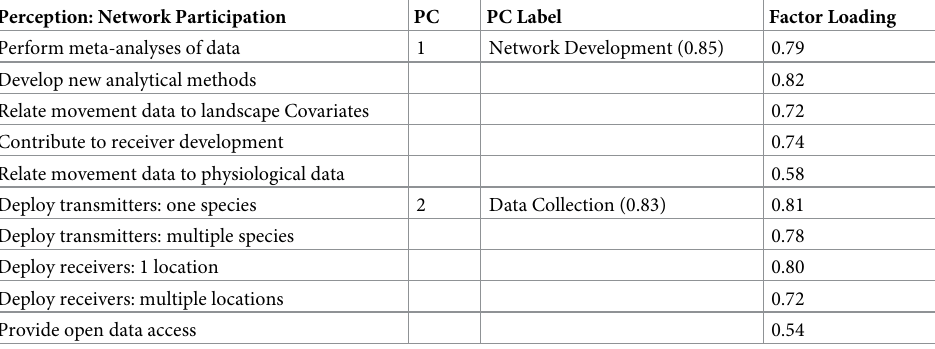
Table 3. Survey participants scored perceptions of how they might interact with various aspects of a nationally coordinated network, where responses ranged from 0 (not likely to participate) to 10 (high likelihood of